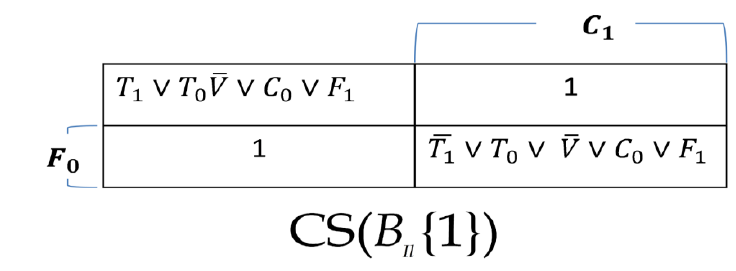
Fig. 14. The VEKM in Fig. 13 after being folded w.r.t. 𝐹